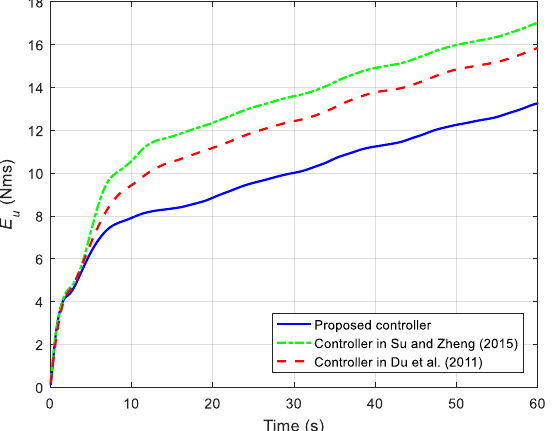
E [18,21]. Figure 10. Profile of the energy consumption index E u u E [18,21]. u